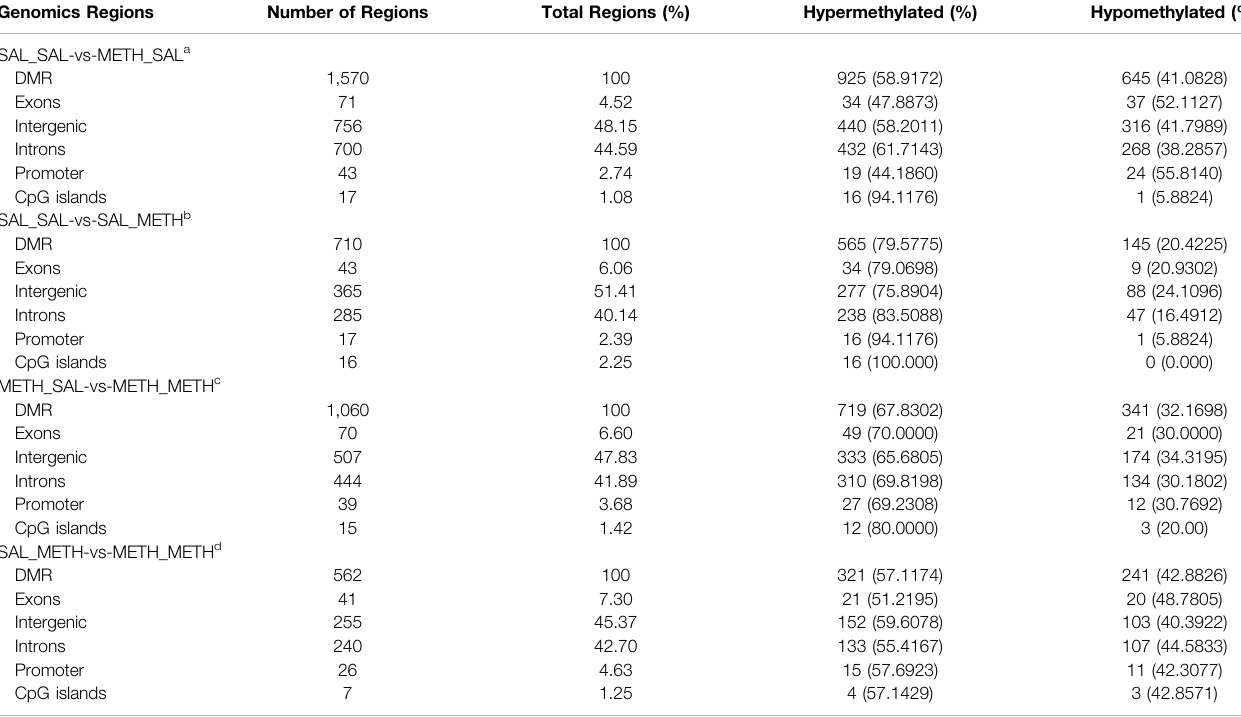
TABLE 1 | Genomic distribution of DMR measured by WGBS in adult offspring prenatally or postnatally exposed to METH compared to corresponding control group. Genomics Regions Number of Regions Total Regions